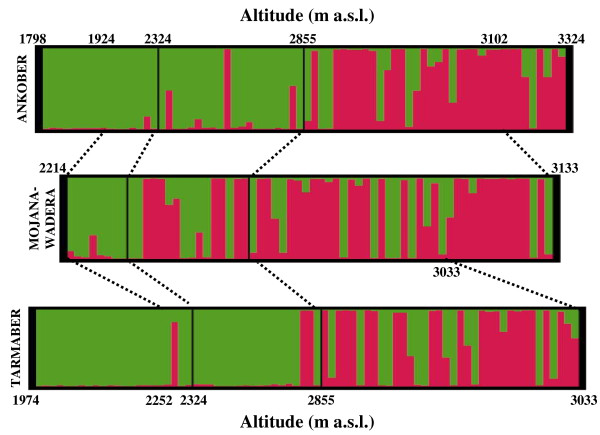
Population structure across districts and altitudes using STRUCTURE. STRUCTURE assignment at K = 2 for the individuals collected in the three districts (Ankober, Mojanawadera and Tarmaber), ordered according to crescent altitude levels. Green, cluster S1; red, cluster S2.